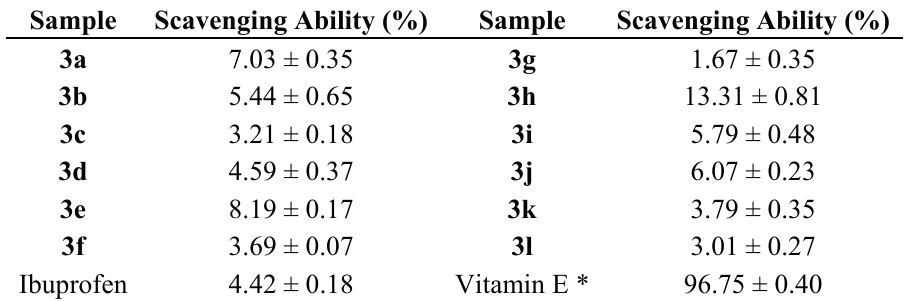
Table 6. The ABTS radical scavenging ability of the acyl hydrazone derivatives 3a – l .